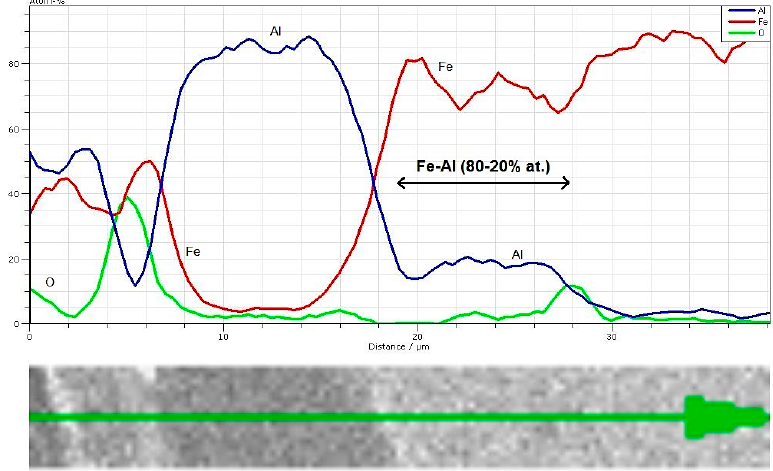
Figure 9. Linear distribution of elements in the crystal boundary, confirming the presence of the Fe-Al phase, with a composition of about 80–20%.